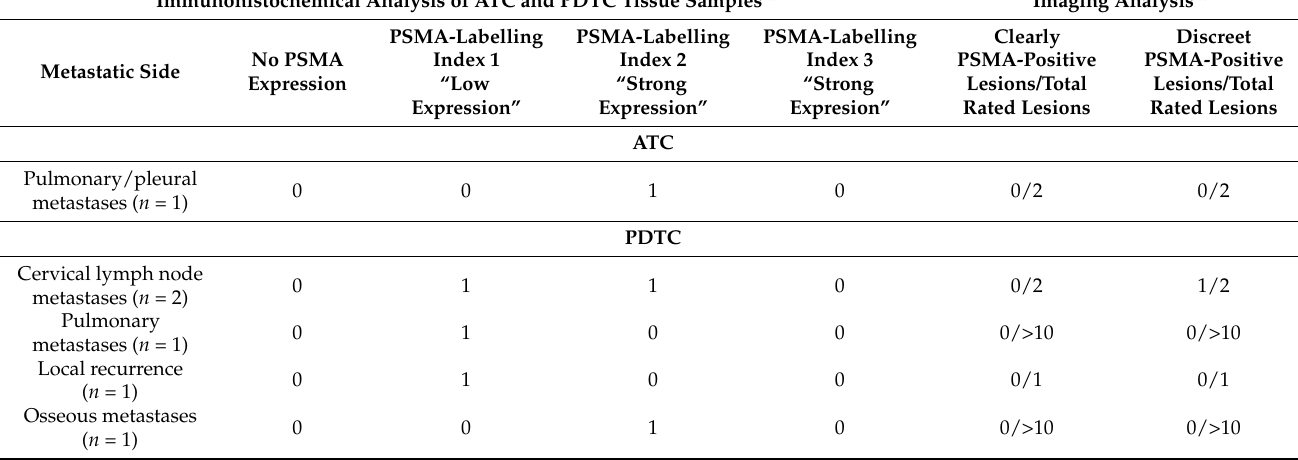
Table 4. Correlation between the extent of immunohistochemical PSMA expression and imaging in 68 Ga-PSMA-PET/CT with regard to different metastatic sides of ATC and PDTC